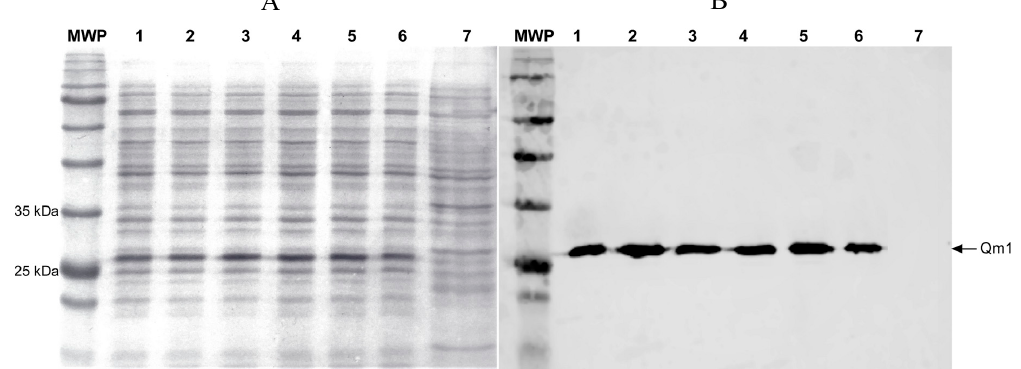
Figure 6. The expression analysis of Chimera 1 (Qm1) in Escherichia coli (SHu ffl e ® T7 Express)